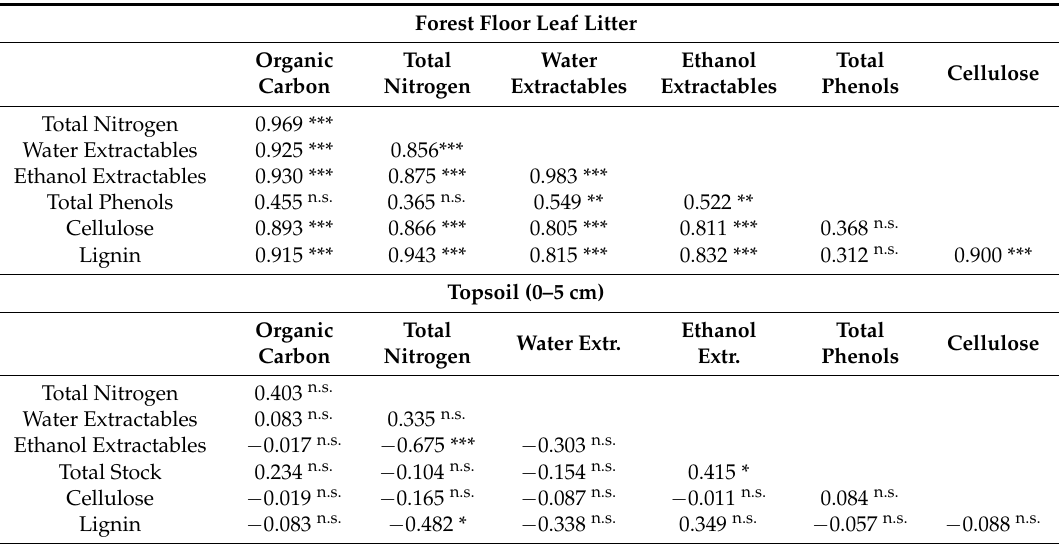
Table 3. Pearson correlation coefficients between the different stocks in the forest floor leaf litter and topsoil. Values in brackets are the significance of the correlation, highlighted by